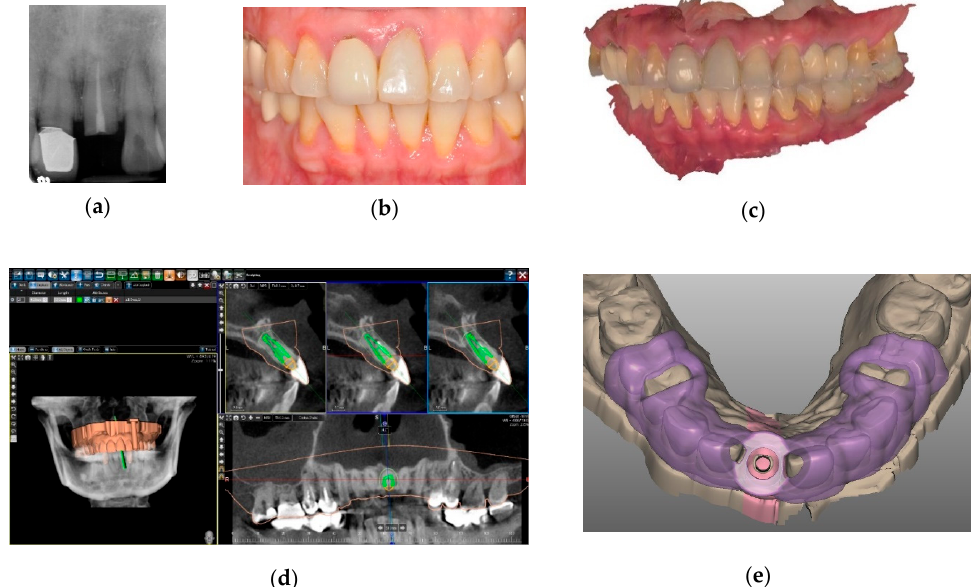
Figure 1. Surface registration protocol of implant planning. ( a ) A radiograph of a fractured left maxillary central incisor. ( b ) A temporary restoration for esthetics was fabricated on the root with fiber post and resin composite. ( c ) An image of maxillary and mandibular digital impressions after occlusal registration. ( d ) A cone-beam computed tomography (CBCT) image matched with an intraoral scan by dental surface registration algorithm, with ideal implant position planned (green). ( e ) A computer-aided design (CAD) image of the designed surgical guide.